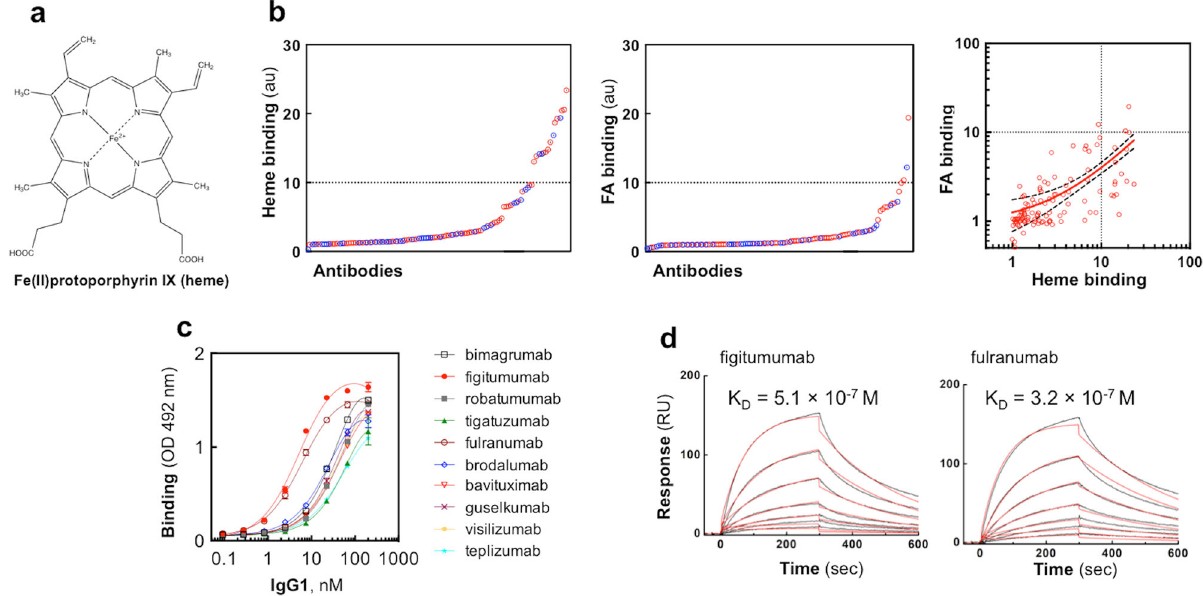
Fig. 1 Interaction of heme with therapeutic Abs. a Structural formula of Fe-protoporphyrin IX (heme). b Interaction of the repertoire of monoclonal IgG1 therapeutic antibodies to immobilized heme (left panel) and FA (right panel). Each circle on the panels represents the average binding intensity of a given therapeutic Ab analyzed in duplicate. The binding intensity for each Ab is obtained by division of reactivity to cofactor-conjugated gelatine by the reactivity of Ab to gelatine alone. The dashed line represents the tenfold increased binding over binding to gelatine alone. The right panel depicts the correlation of the binding to FA versus the binding to heme. The red circles represent Abs that are currently in clinical trials. The blue circles indicated the clinically approved Abs. The Spearman correlation analyses ρ = 0.69, P < 0.0001 — indicates a signi fi cant correlation between the two parameters. The dashed lines display the 95%, con fi dence band. c Concentration-dependent binding of Abs to immobilized heme. The selected ten Abs were identi fi ed as top binders in the high-throughput heme-binding assay (panel b ). Increasing concentrations 0.09 – 200 nM of the selected Abs were incubated with a heme-coated surface or with the control surface. Nonlinear regression analyses were performed by GraphPad Prism v.6 software. Each circle on the panels represents the average binding intensity ±SD of a given therapeutic Ab analyzed in duplicate. d Real-time interaction pro fi les of binding of heme to immobilized Abs ( fi gitumumab and fulranumab). The black line depicts the binding pro fi les obtained after injection of serial dilutions of hemin (1250 – 19.5 nM). The red lines depict the fi ts of data obtained by global analysis using the Langmuir kinetic